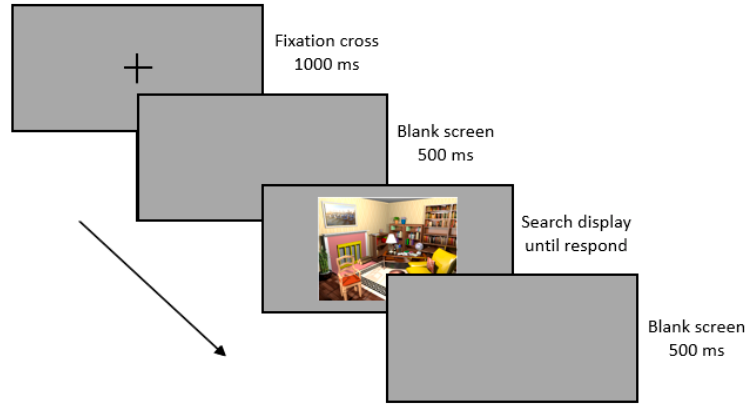
Figure 2. Top : Example trial.